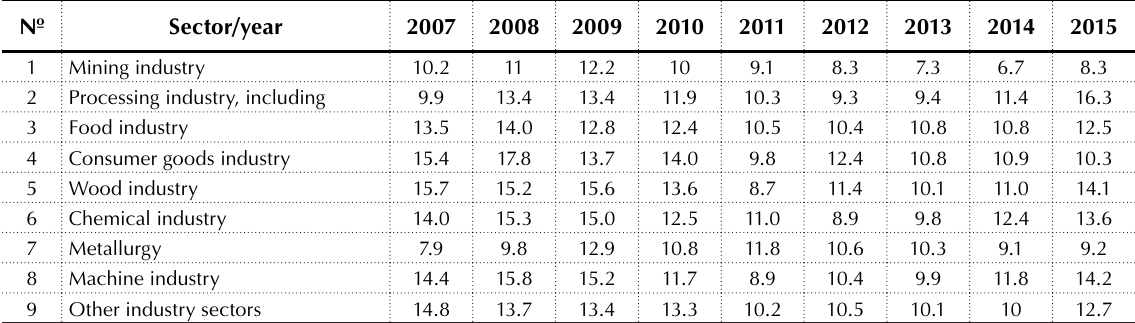
Table 6. Average weighted rate on loans to banks in the context of industrial sectors, %